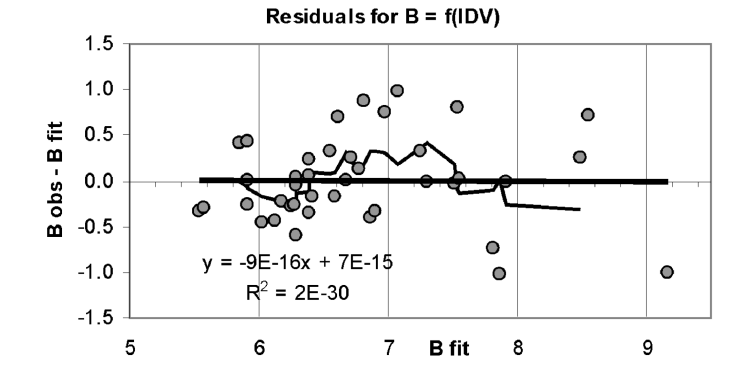
Figure 23: Analysis by Svalgaard and Cliver (2006) of the fit residuals in the fit of 𝐼𝐷𝑉 against 𝐵 by Svalgaard and Cliver (2005). The fit residuals are plotted as a function of the fitted value, which is the correct test for homoscedasticity. Image reproduced by permission from Svalgaard and Cliver (2006), copyright by